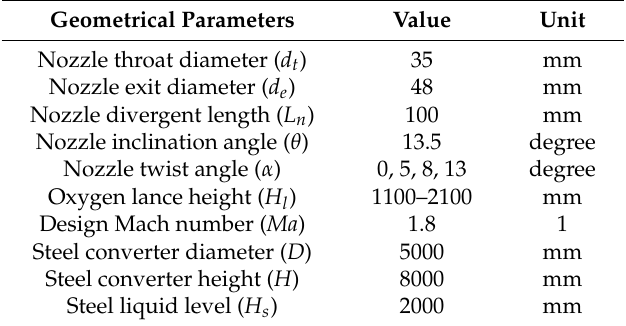
Figure 2. Steel converter and multi-nozzle oxygen lances geometrical models: ( a ) oxygen top-blown converter steelmaking; ( b ) magnified view of area A with a conventional oxygen lance and ( c ) a nozzle-twisted lance. Table 1. Geometrical parameters of multi-nozzle oxygen lance and steel converter.